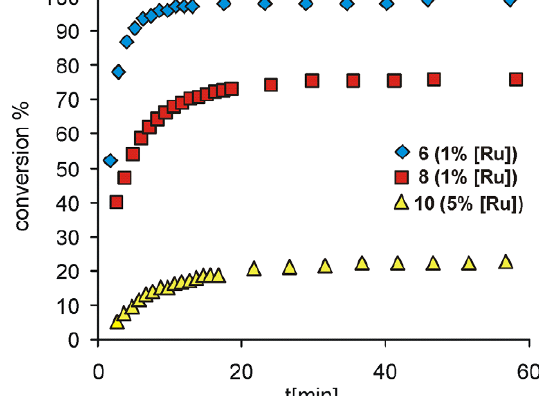
Figure 1. Kinetic profiles of RCM of 6 , 8 , 10 0.1 M, conducted in CD